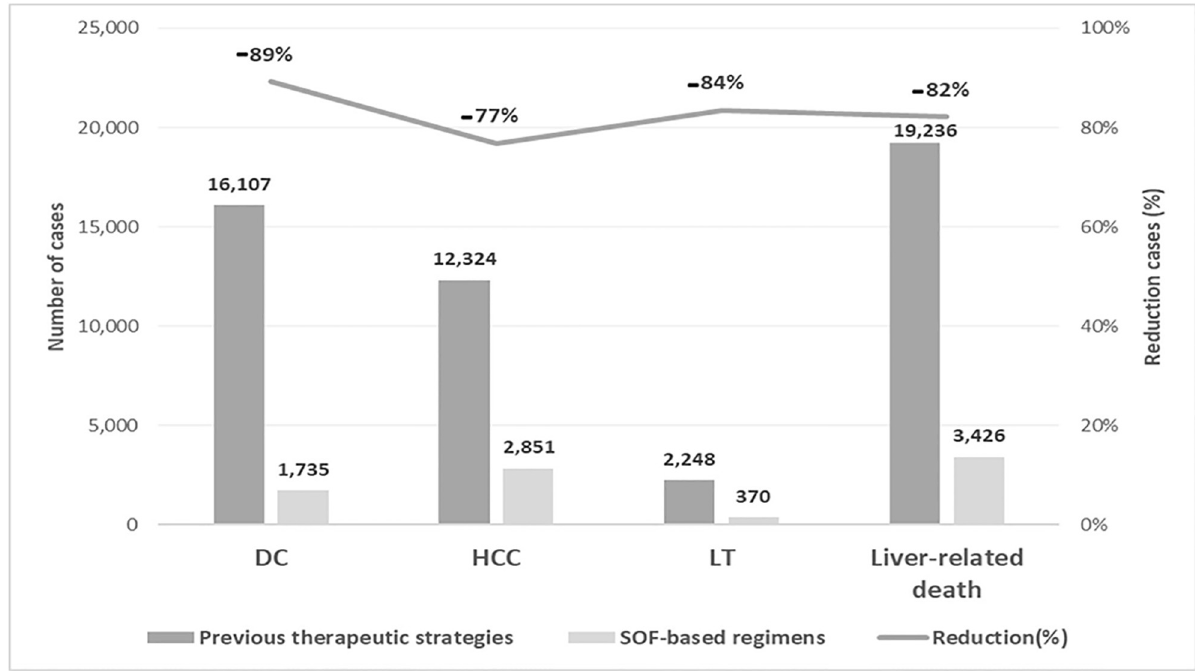
Fig 1. Number of clinical events and reduction in clinical events cases between both strategies for the total cohort. DC, decompensate cirrhosis; HCC, hepatocellular carcinoma; LT, liver